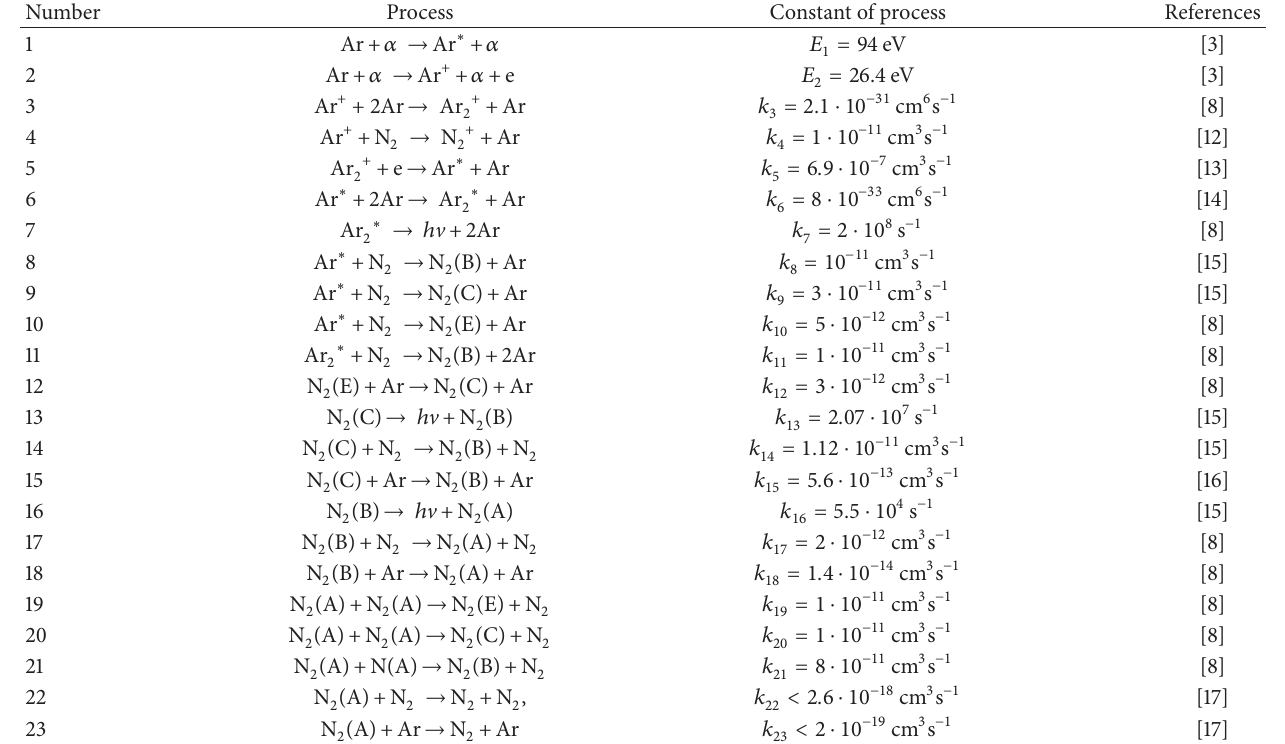
Table 1: Rate constants of processes in an Ar-N 2 mixture.